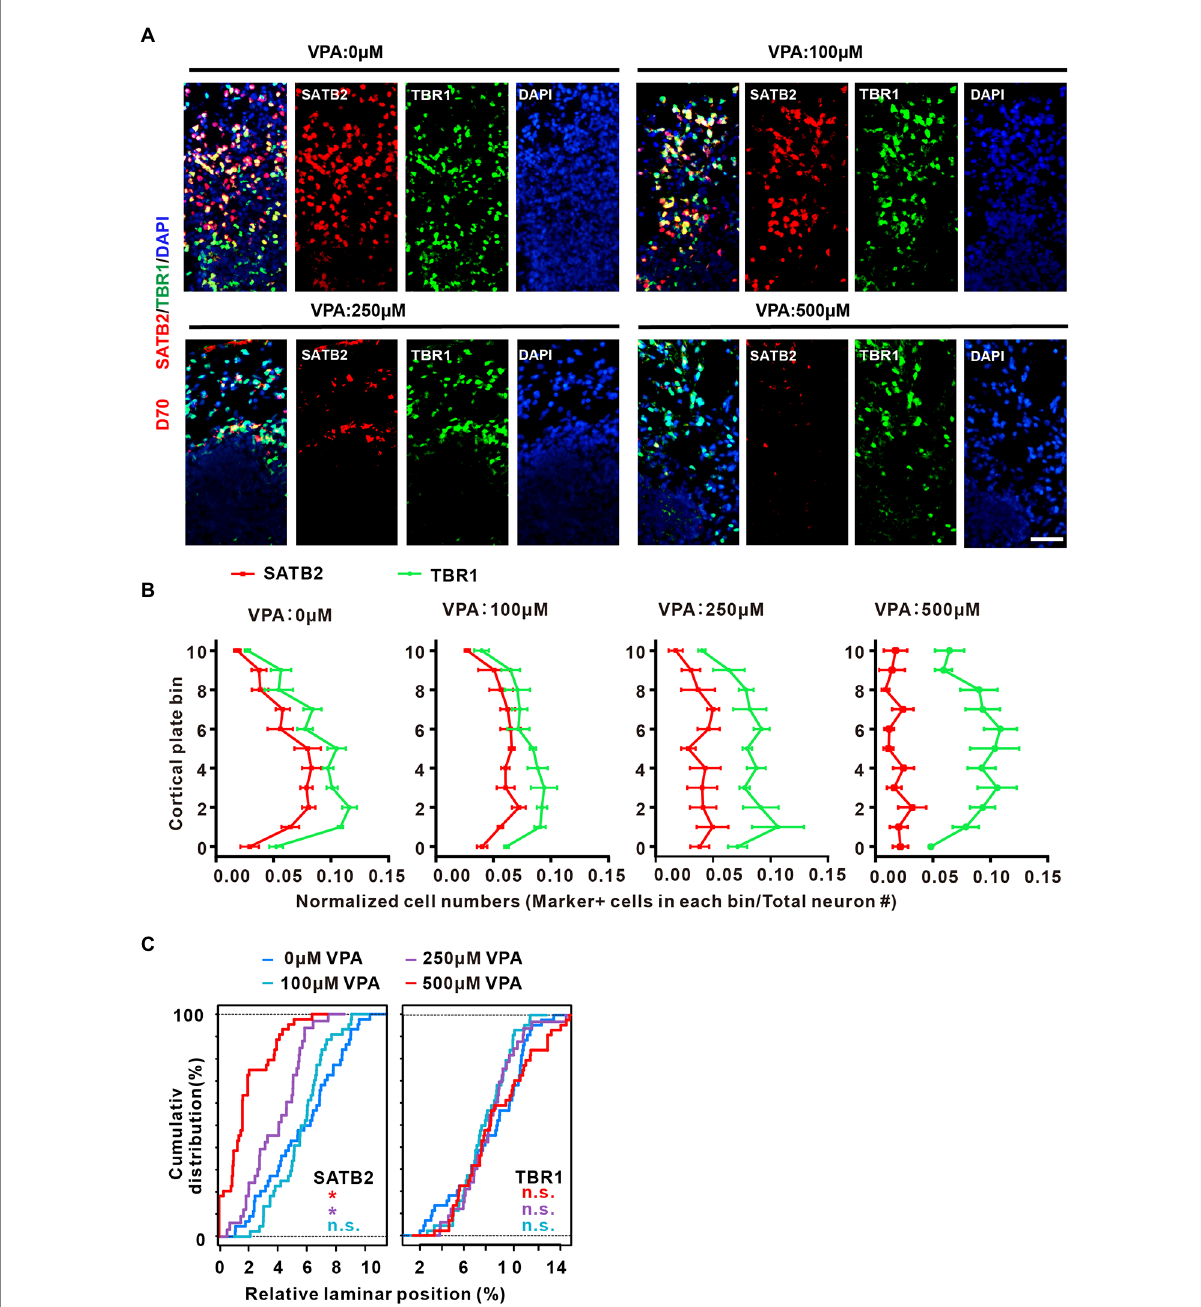
FIGURE 6 VPA exposure caused disorganization of cortical lamination and loss of up-layer neurons in dorsal forebrain organoids. (A) Representative image of 0, 100, 250, and 500 μ M VPA treated human dorsal forebrain organoids for SATB2 and TBR1 at day 70 (0, 100, and 500 μ M: n = 4 organoids; 250 μ M, n = 3 organoids). Scale bar, 50 μ m. (B) Quantifications of the location of SATB2 + and TBR1 + cells in the CP of human dorsal forebrain organoids with different concentrations of VPA. The CP area is equally divided into 11 equal bins; bins 0–10 follow the direction from apical to basal. The curves indicate the normalized abundance in each bin, computed as marker + cell number in a bin/total neuron number. (C) Kolmogorov–Smirnov tests were conducted for the VPA-exposed conditions, referred as the corresponding color, against the 0 μ M condition (n.s.: p > 0.05; * p <